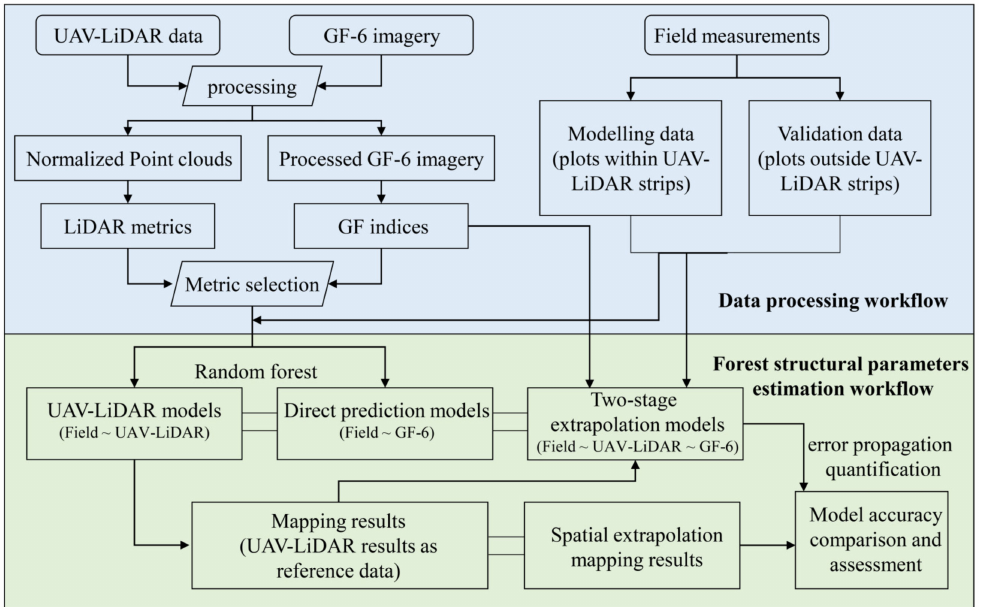
Figure 3. The workflow of forest structural parameter estimation in combination with field plots, UAV-LiDAR, and GF-6